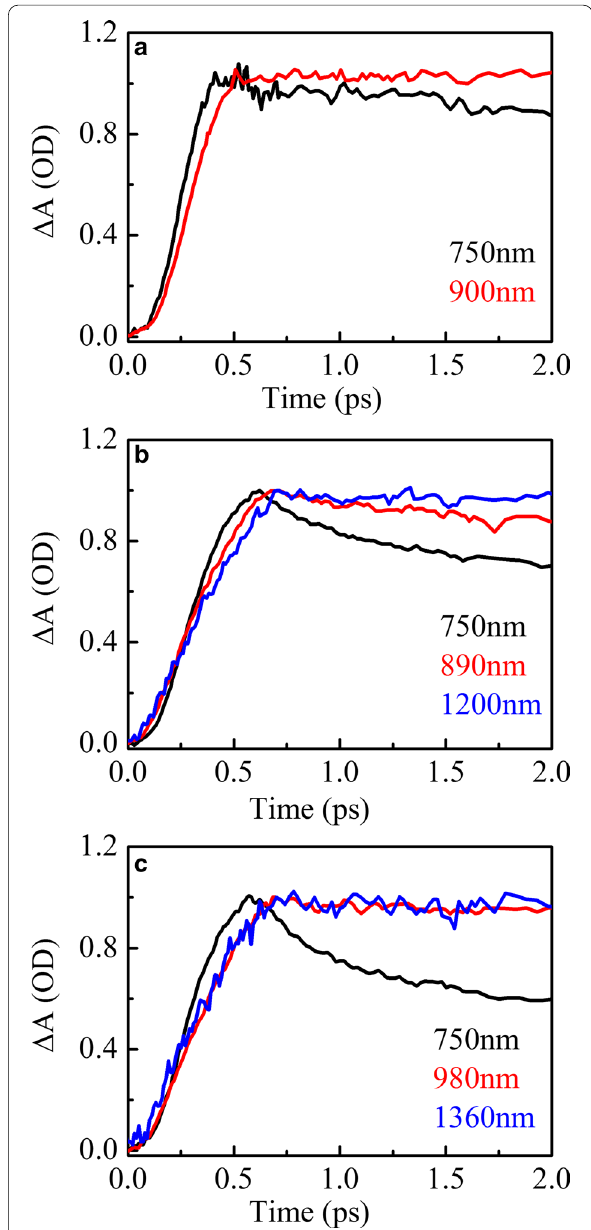
Fig. 6 Transient absorption EX (black) and CT (red) and CT ′ (blue) kinetics for HSD-A ( a ) and HSD-B ( b ) and HSD-C ( c ), exhibiting the EX decay simultaneously with the increase in CT and CT